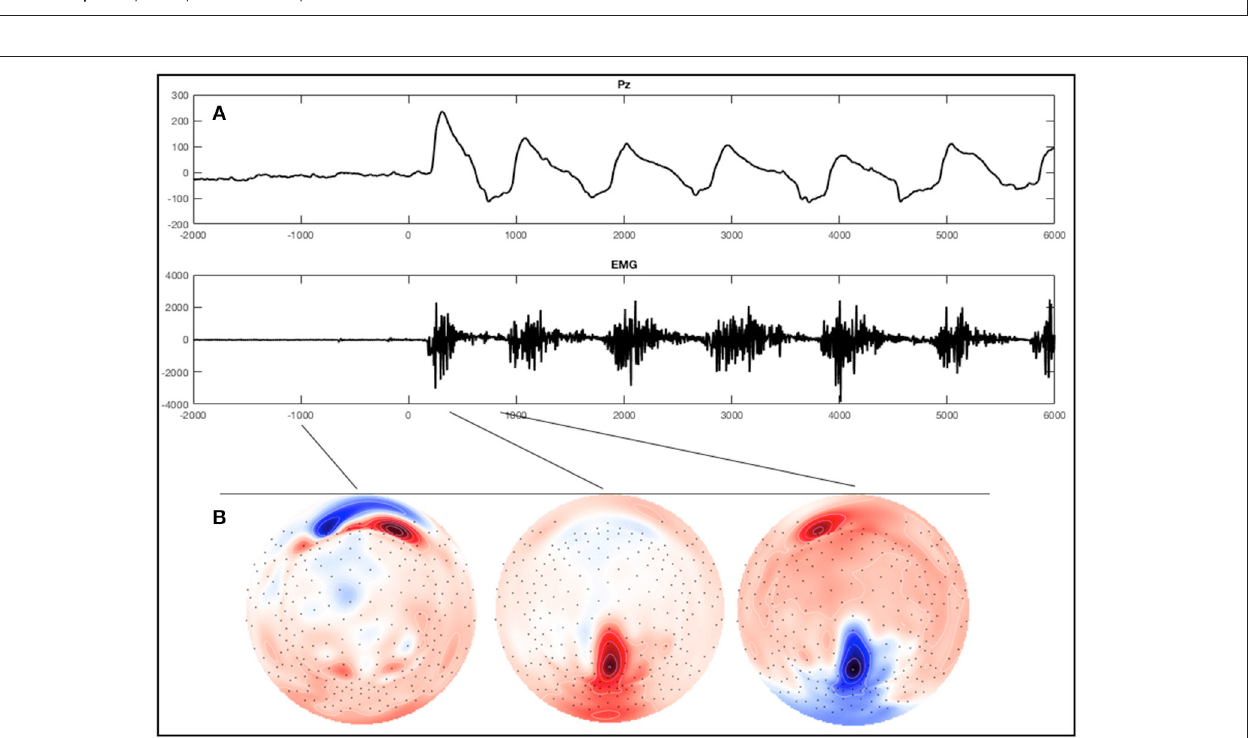
FIGURE 2 | Example of an ERP of a healthy subject during the foot movement condition. On the top (A) a single trial response on Pz and the EMG with regard to stimulus onset (time point 0) is shown. The x-axes display time (ms) and the y-axes amplitudes ( µ V). On the bottom (B) , activation maps of the averaged signal can be